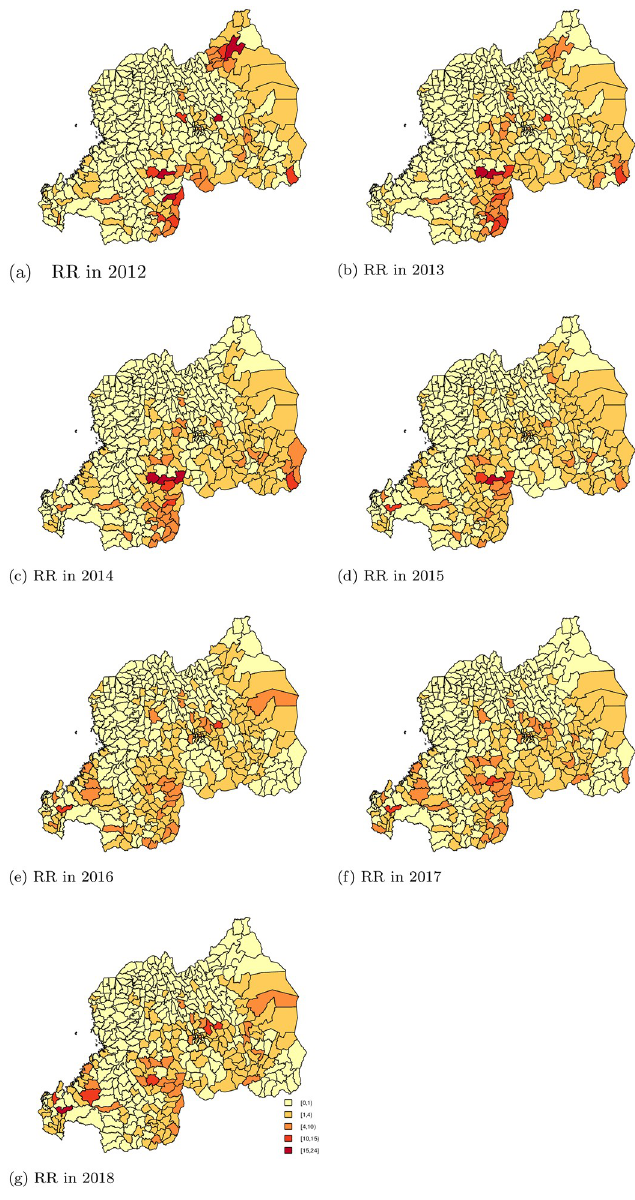
Fig 2. Malaria relative risk from year 2012 to